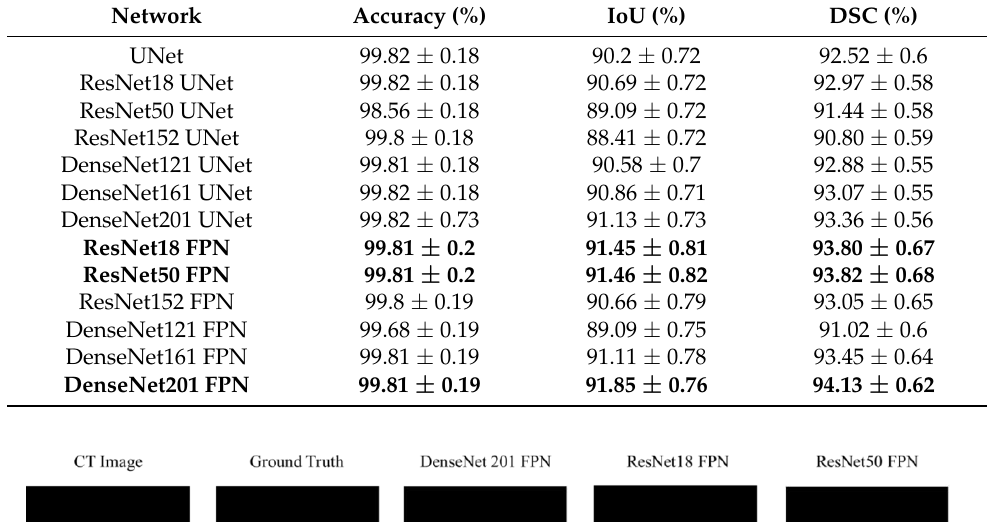
Table 6. Results of 10-fold cross-validation of Lesion Segmentation (Best results are formatted in Bold).